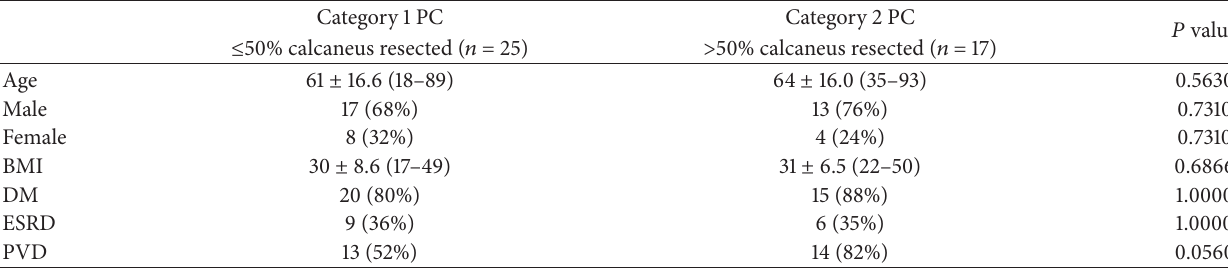
Table 1: Demographics and medical history.